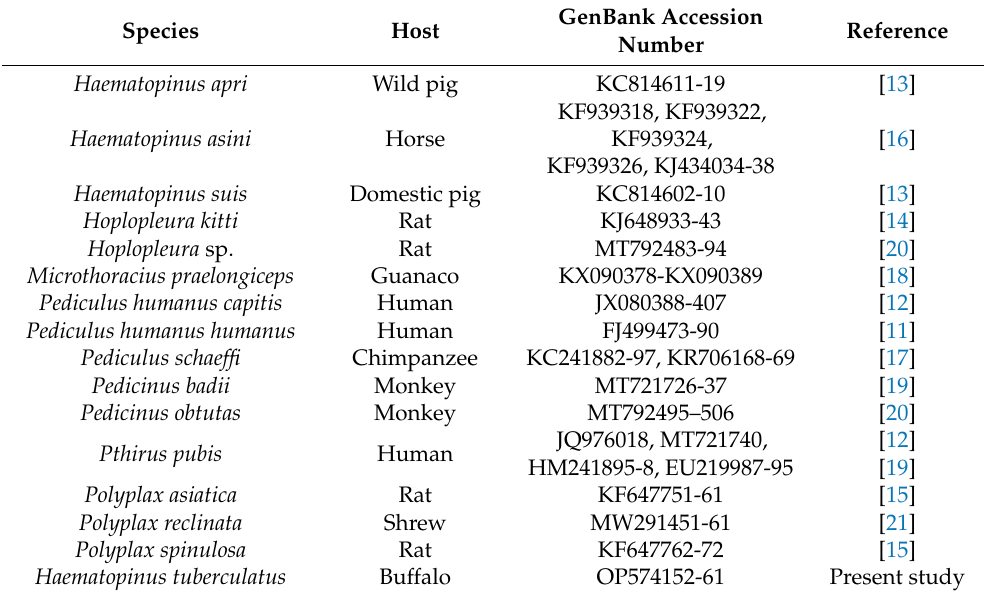
Table 3. The sucking lice included in phylogenetic analyses in this